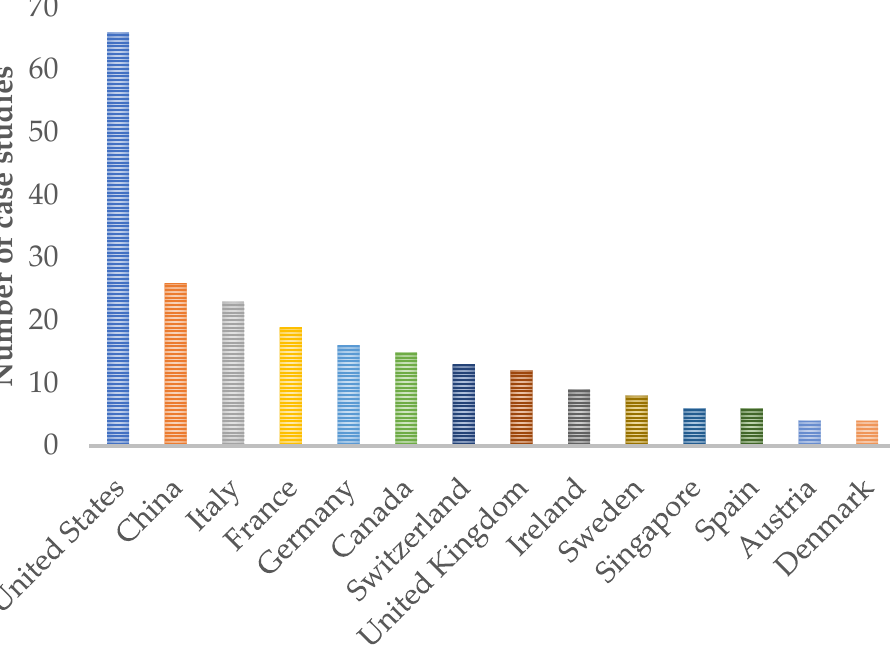
Figure 19. Location of physics-based urban building energy modeling case studies. 3.5. Archetype Development in UBEM Archetype or prototype building development is one of the most effective ap- proaches in reducing the complexity and preparation time for UBEM development. Alt- hough it might reduce the accuracy of outcomes due to deviation from the individual building characteristics by up to 17% [56], it could still be a practical approach with ac- ceptable accuracy. Different classification and clustering methods are used to create these archetype buildings [57] based on various inputs such as building vintage, type, and square footage. Review studies on building archetype development show that the most common variables used in developing construction archetypes include construction ty- pology (e.g., commercial or residential), construction year (i.e., vintage), end-use, size of the building, and heating systems [29]. The identified archetypes would be affected by the deployed methodology. Goy et al. (2021) [58] compared unsupervised, semi-supervised, and supervised methods to de- velop building archetype development. They observed that the algorithms and the se-